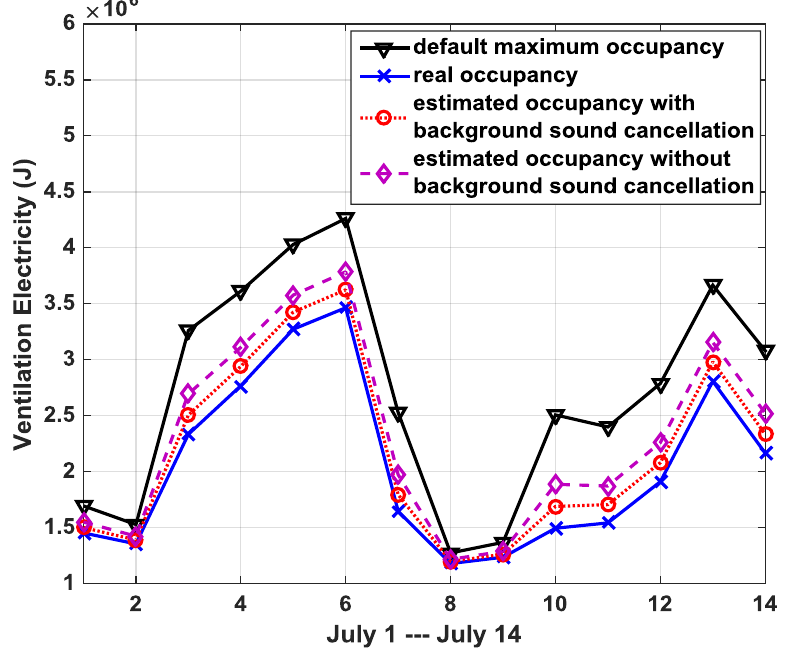
Figure 9. Simulation results of daily ventilation electricity for two weeks in July.